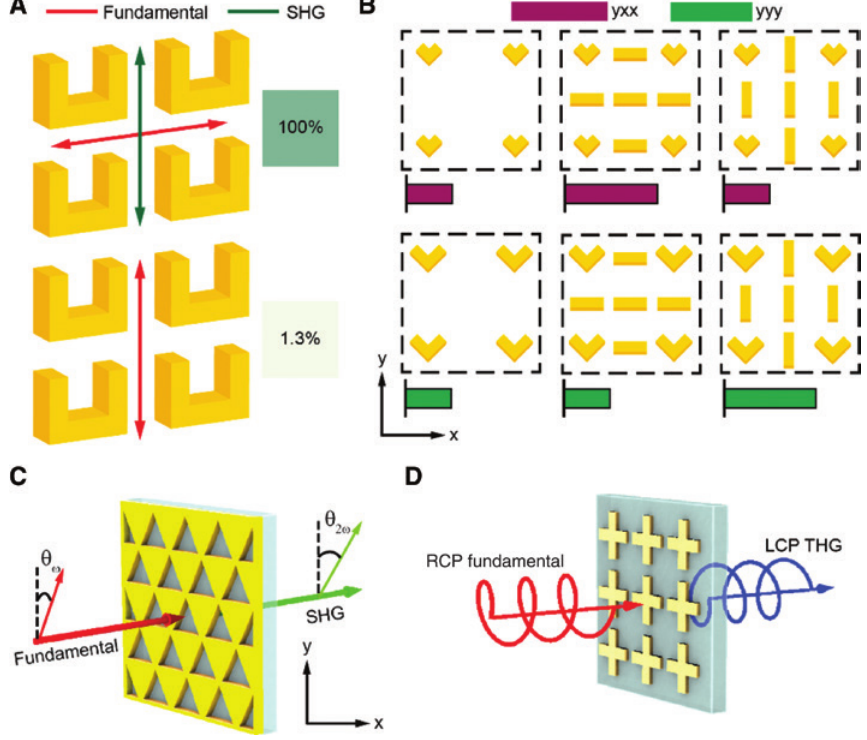
Figure 1: Symmetry consideration in nonlinear plasmonic metasurfaces. (A) SHG from gold SRRs; (B) SHG from V-shaped plasmonic metasurface; (C) for plasmonic meta-atom with C3 rotational symmetry, the polarization direction of SHG wave exhibits the effect of nonlinear optical activity; (D) for plasmonic meta-atom with C4 rotational symmetry, helicity of THG is opposite to that of FW. A is adapted from Ref. [49], B from Ref. [58], C from Ref. [59], and D from Ref.